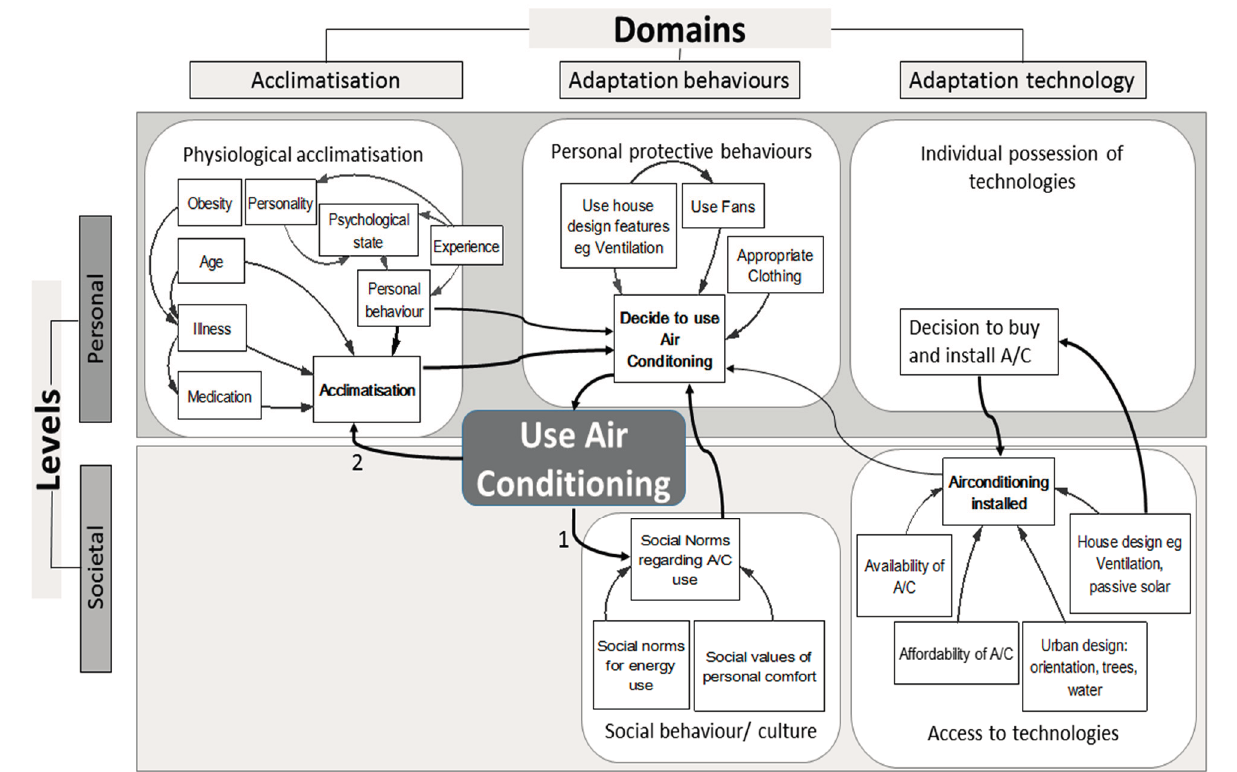
Figure 3: Climate change adaptation conceptual framework expanded model, provides an example of application of this framework, showing subsystem elements within each level and domain, using the example of A/C. Arrows depict influence flows that lead to use of A/C. Numbers represent the feedback loops discussed